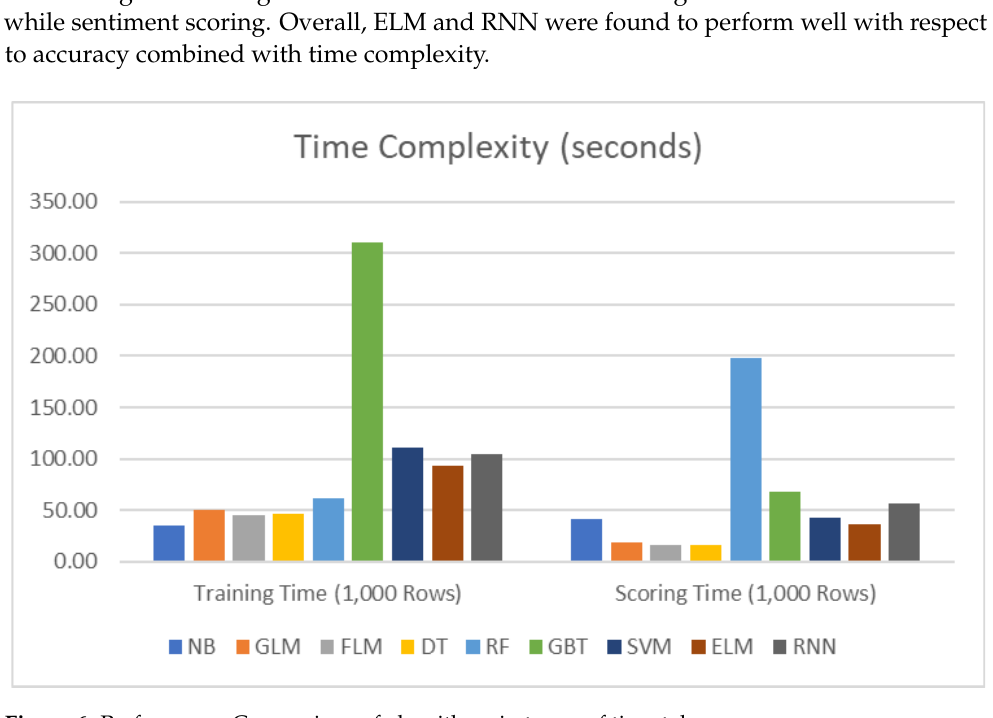
Figure 6. Performance Comparison of algorithms in terms of time taken.